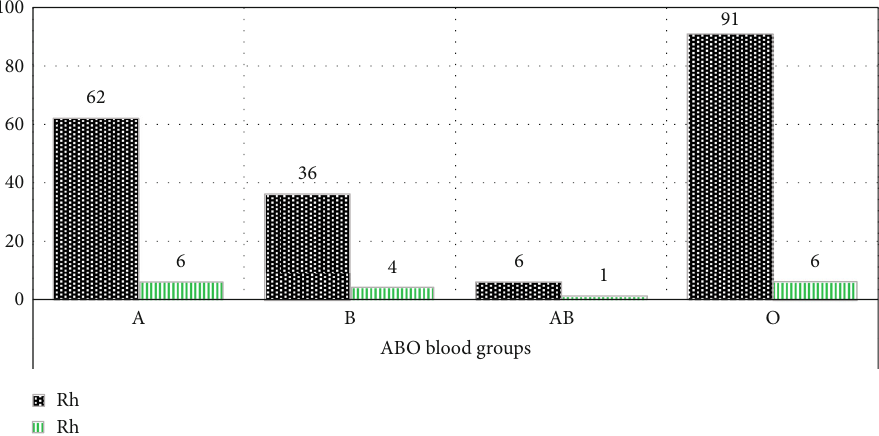
Figure 2: Frequency of the ABO and Rh blood group phenotypes among healthy controls. Table 2: The association of ABO blood group phenotypes with T2DM at FHCRH, Bahir Dar, northwest Ethiopia, 2019 ( n = 424 ). Blood